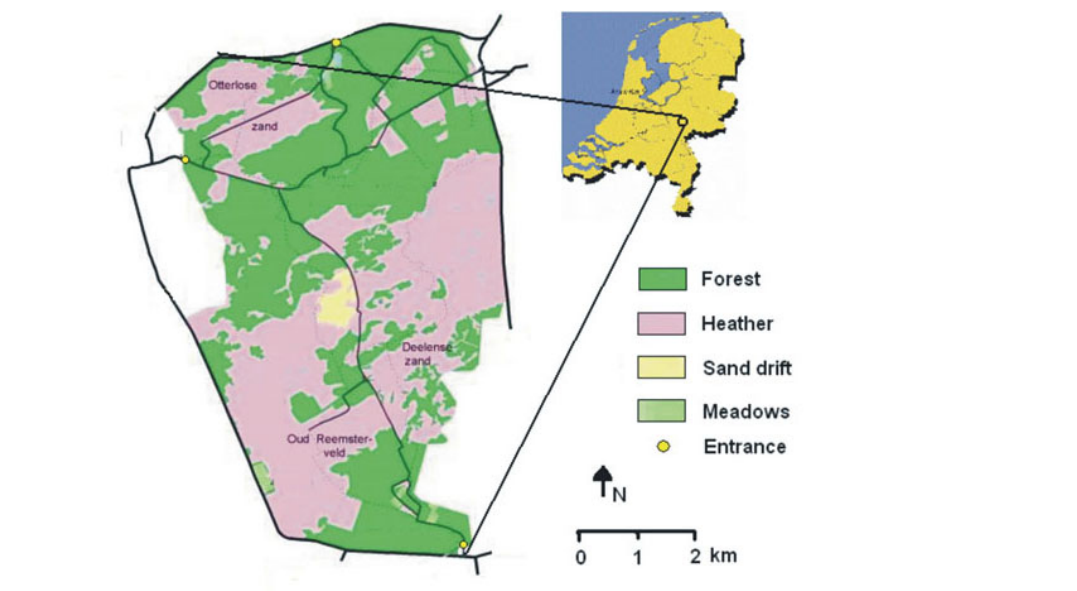
Fig. 1 . Map and location of the Hoge Veluwe national